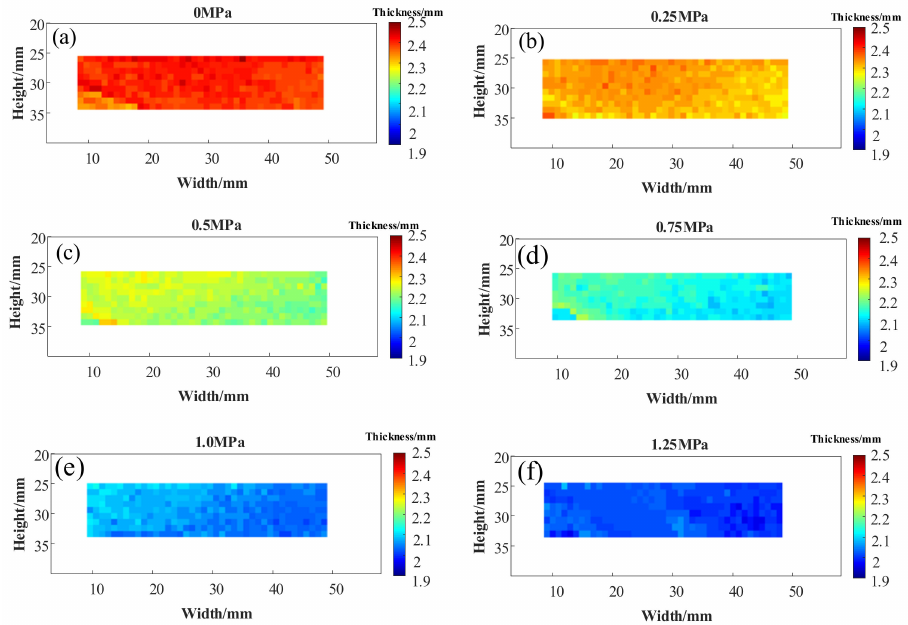
Figure 10. Thickness distribution of adhesive film under different tensile stress. ( a ) the thickness distribution under 0 Mpa tensile loads. ( b ) the thickness distribution under 0.25 Mpa tensile loads. ( c ) the thickness distribution under 0.5 Mpa tensile loads. ( d ) the thickness distribution under 0.75 Mpa tensile loads. ( e ) the thickness distribution under 1.0 Mpa tensile loads. ( f ) the thickness distribution under 1.25 Mpa tensile loads.